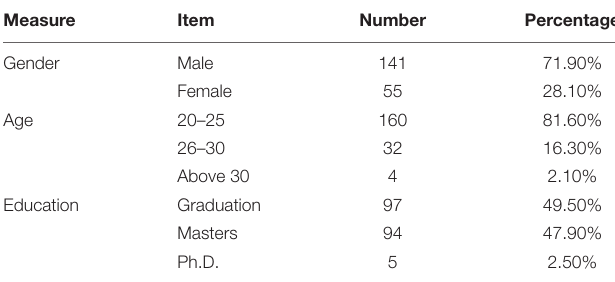
TABLE 2 | Descriptive profile of